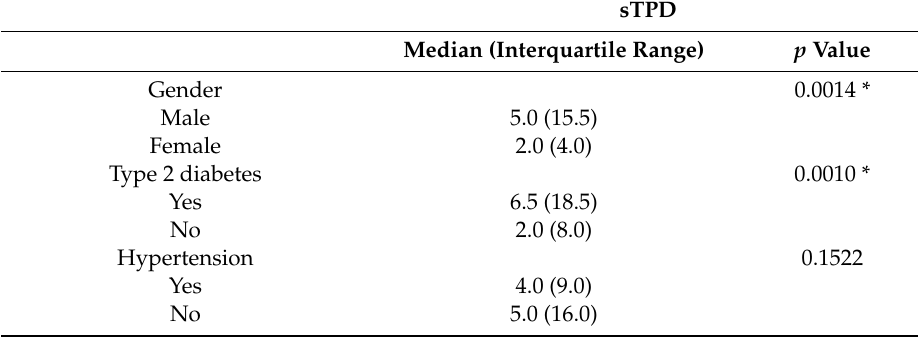
Table 3. Differences in sTPD according to different clinical settings analyzed using Mann–Whitney U tests.